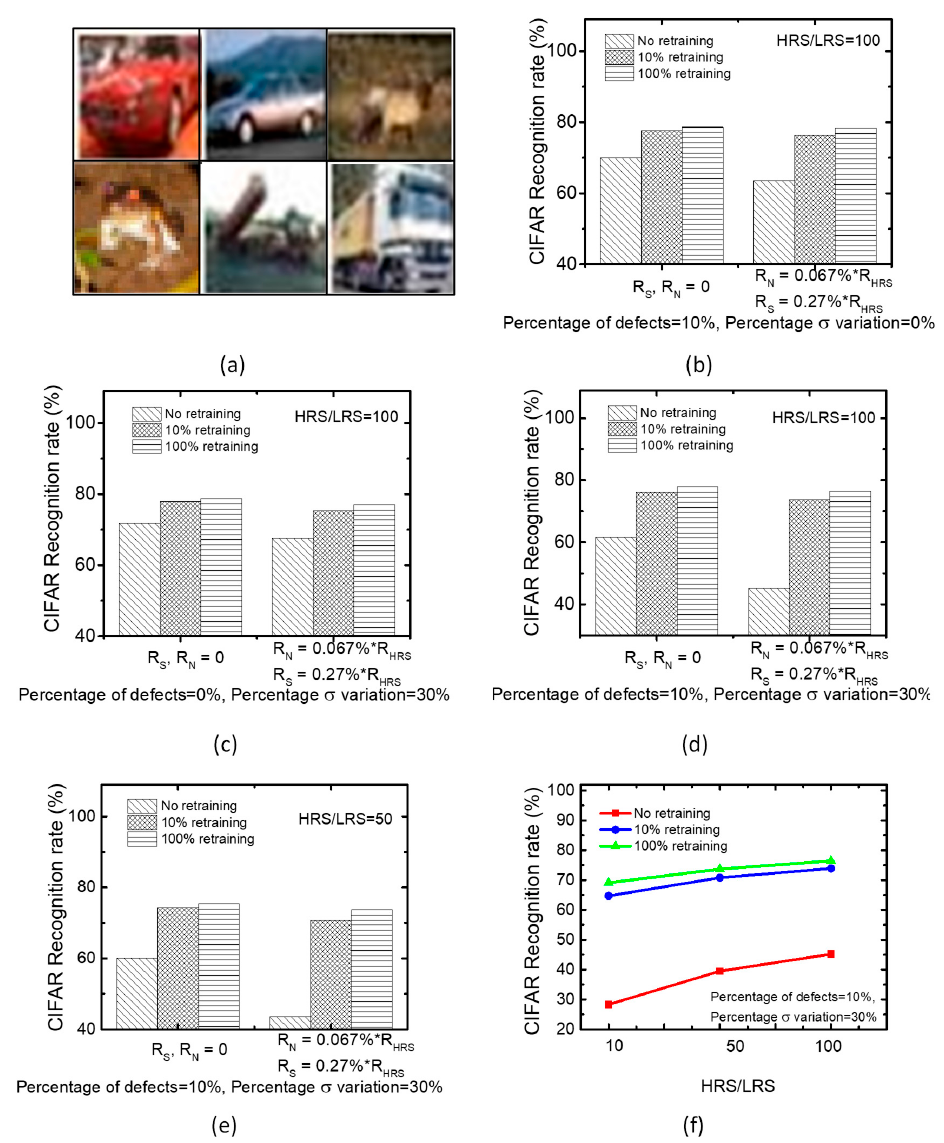
Figure 7. ( a ) The CIFAR-10 image samples ( b ) The CIFAR-10 recognition rates of the ideal (R N = R S = 0) and non-ideal (R N = 0.067% of R HRS , R S = 0.27% of R HRS ) crossbars for the percentage of stuck defects = 10% and the percentage σ variation in weights = 0%.Here, HRS/LRS = 100. ( c ) The CIFAR-10 recognition rates of the ideal (R N = R S = 0) and non-ideal (R N = 0.067% of R HRS , R S = 0.27% of R HRS ) crossbars for the percentage of stuck defects = 0% and the percentage σ variation in weights = 30%. Here, HRS/LRS = 100. ( d ) The CIFAR-10 recognition rates of the ideal (R N = R S = 0) and non-ideal (R N = 0.067% of R HRS , R S = 0.27% of R HRS ) crossbars when considering both the percentage of stuck defects = 10% and the percentage σ variation in weights = 30%. Here, HRS/LRS = 100. ( e ) The CIFAR-10 recognition rates of the ideal (R N = R S = 0) and non-ideal (R N = 0.067% of R HRS , R S = 0.27% of R HRS ) crossbars considering the percentage of stuck defects = 10% and the percentage σ variation in weights = 0%. Here, HRS/LRS = 50. ( f ) The CIFAR-10 recognition rate with varying HRS/LRS ratio from 10 to 100.